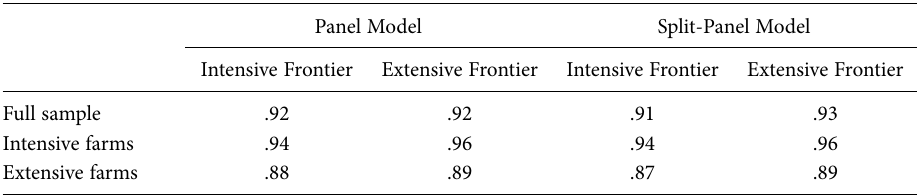
Table 7. Average efficiency of the estimated classes